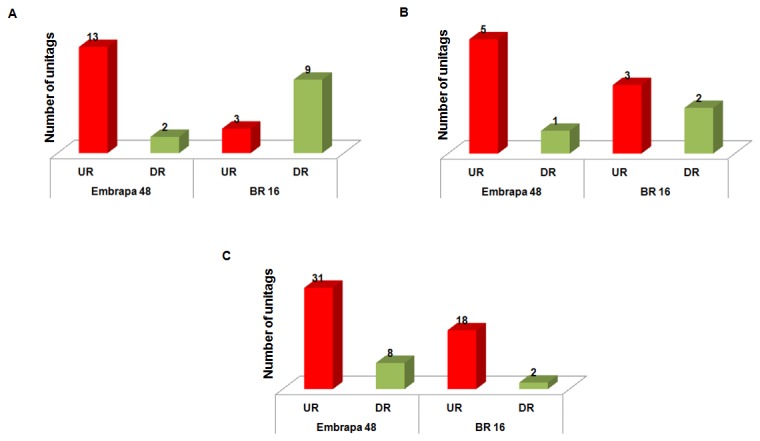
Number of unitags differentially expressed for each accession, and mapped in genomic regions* with predicted coverage by RNA-Seq*. (A) unitags mapped in introns; (B) unitags mapped in exon/intron borders; (C) unitags mapped in genomic regions without any predicted gene.* According to the soybean genome browser (Phytozome database: http://www.phytozome.net/).UR: up-regulated; DR: down-regulated.